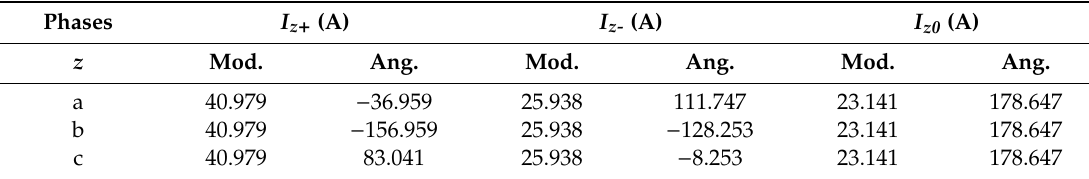
Table 2. Positive-, negative-, and zero-sequence line